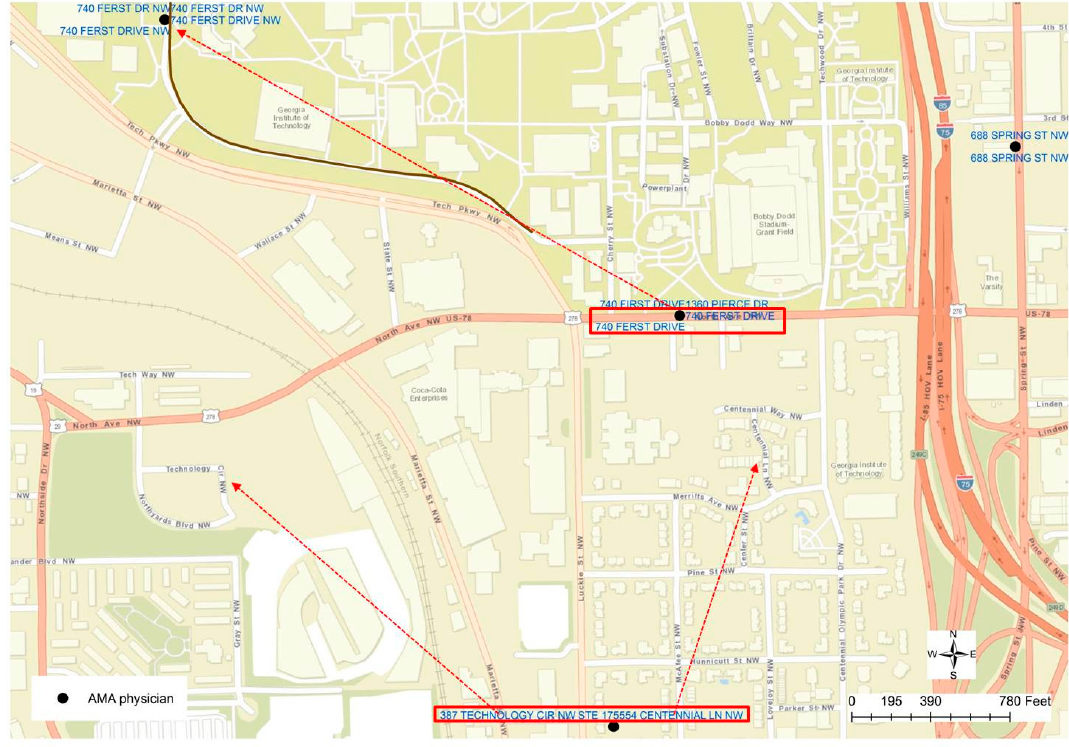
Figure 5. More errors in the geocoding results.